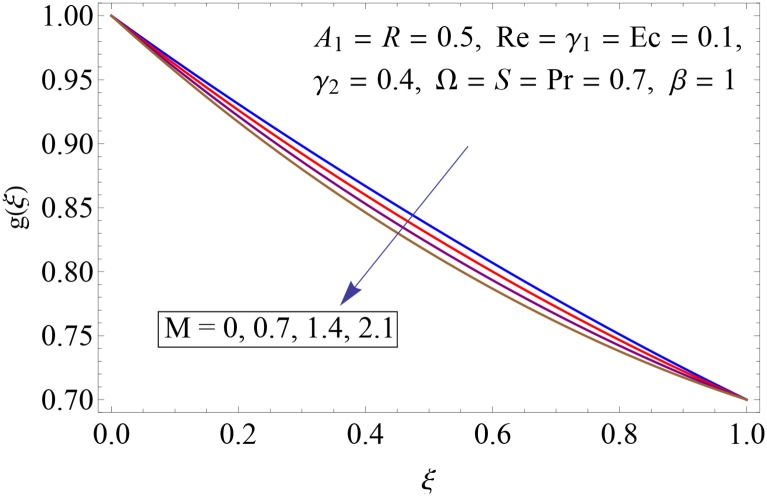
Impact of M on g(ξ).